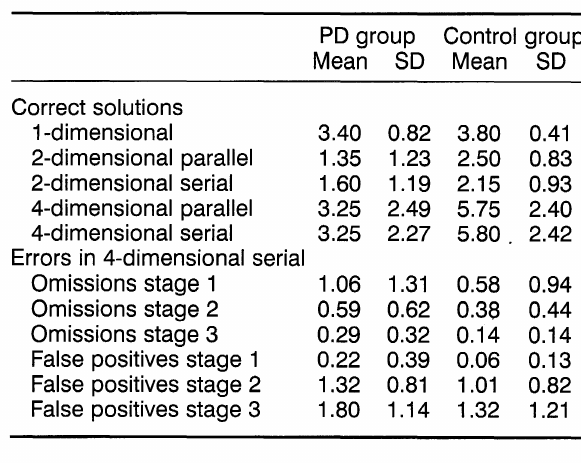
TABLE I: Mean scores and standard deviations for the PD and control subjects on the deductive reasoning prob-